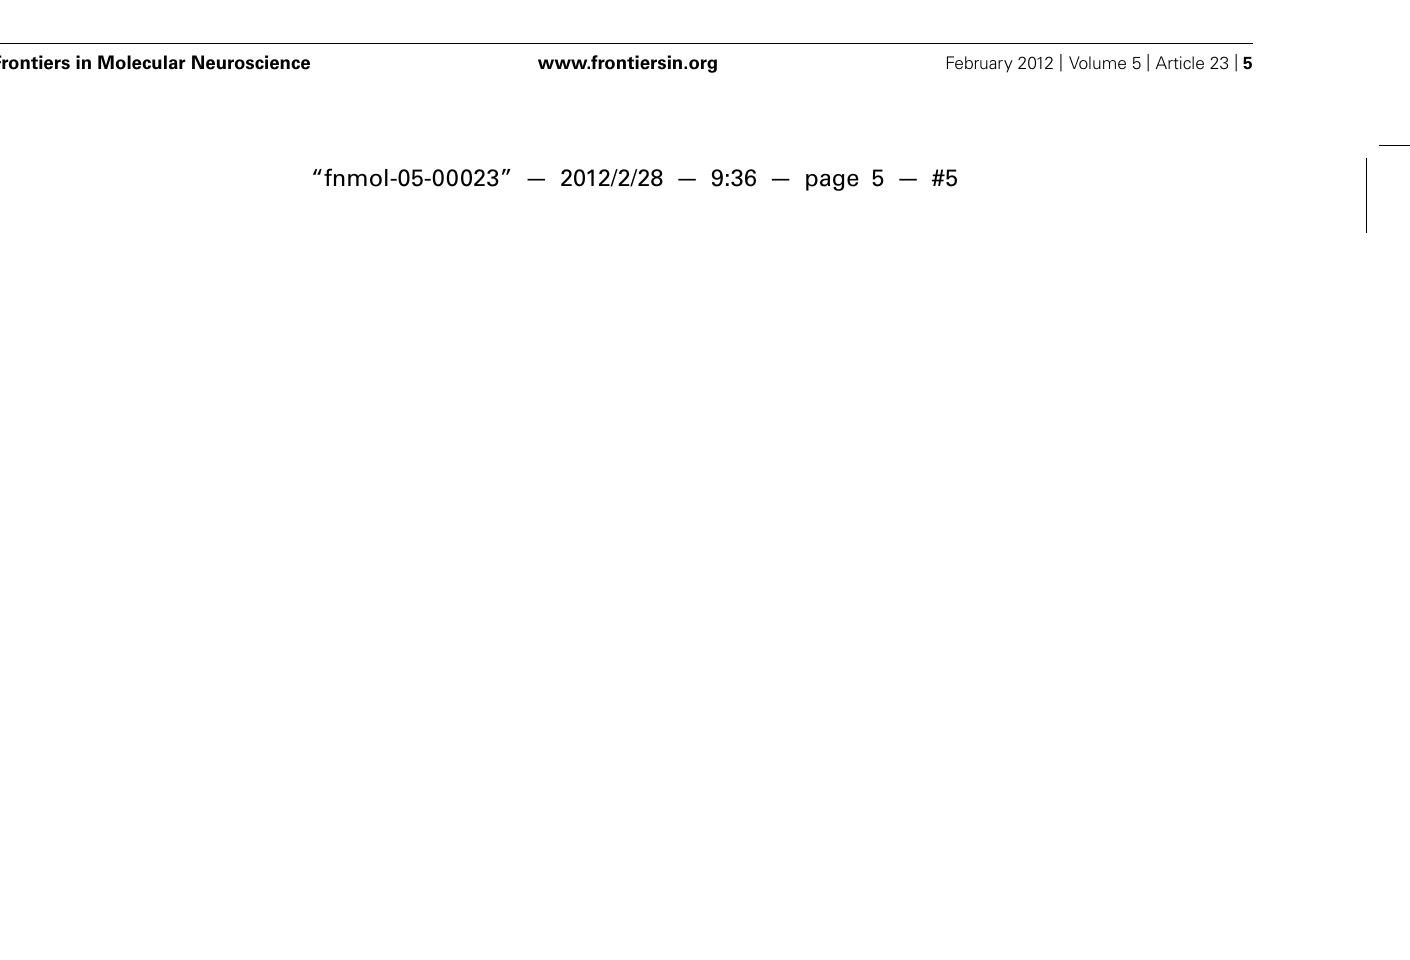
FIGURE 3 | Models for testing circadian metaplasticity. Left :The mammalian SCN has an endogenous circadian rhythm of cAMP and cAMP responsive element (CRE)–luciferase (Luc)-mediated transcription (O’Neill etal., 2008), that are elevated temporally with time-of-day increases in firing rate (Green and Gillette, 1982;Welsh etal., 1995; Quintero etal., 2003; Meredith etal., 2006) and long-term potentiation (LTP; Nishikawa etal., 1995). Drosophila clock cells, the large Lateral Ventral neurons (lLNv) have a similar circadian profile of firing rate (Cao and Nitabach, 2008; Sheeba etal., 2008; Fogle etal., 2011).While Drosophila exhibit robust circadian-driven CRE–Luc activity broadly (Belvin etal., 1999), it is unclear whether cAMP or CRE–Luc activity correlates with this activity in the lLNvs, or if these cells exhibit LTP, based on the time-of-day. Right :